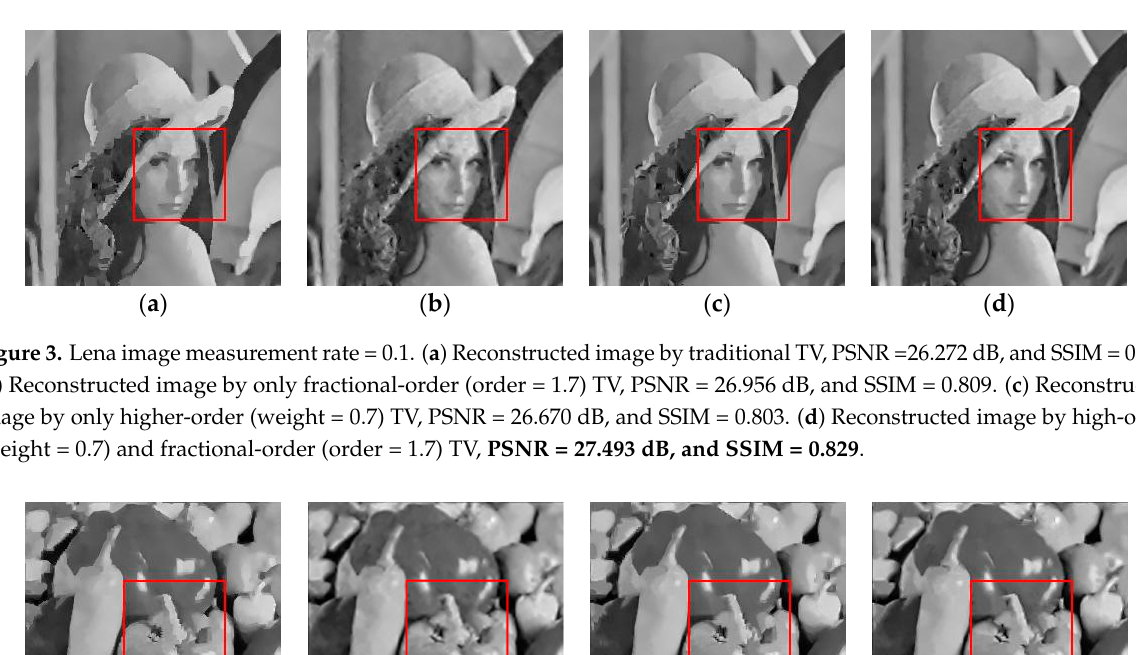
Figure 4. Peppers image measurement rate = 0.1. ( a ) Reconstructed image by traditional TV, PSNR =26.601 dB, and SSIM = 0.829; ( b ) reconstructed image by only fractional-order (order = 1.7)TV, PSNR = 27.748 dB, and SSIM = 0.847; ( c ) reconstructed image by only higher-order (weight = 0.7) TV, PSNR = 26.787 dB, and SSIM = 0.828; ( d ) reconstructed image by high-order (weight = 0.7) and fractional-order (order = 1.7) TV, PSNR = 28.497 dB, and SSIM = 0.868.